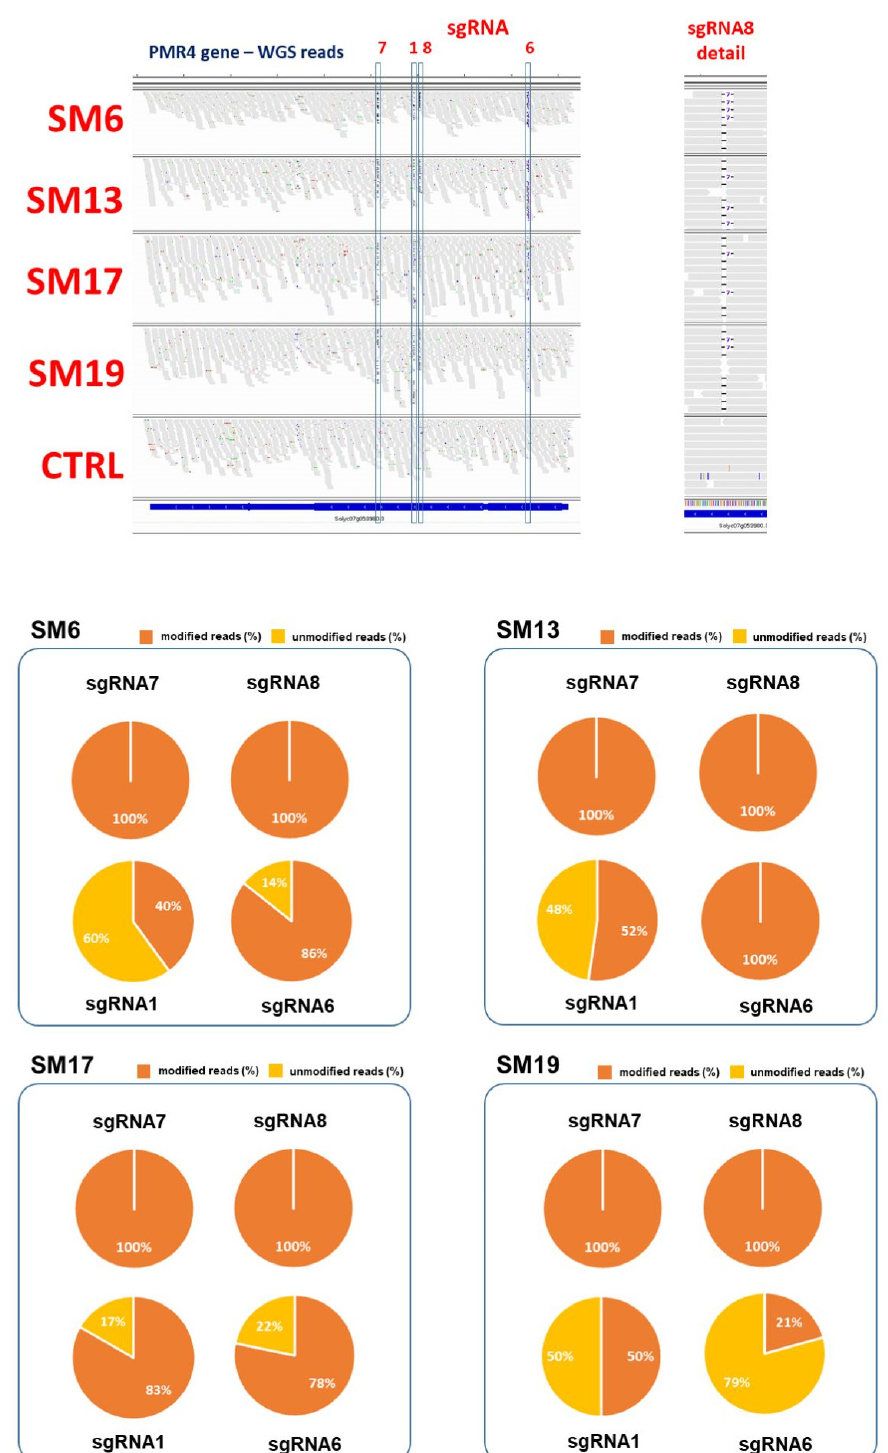
Figure 3. Sequence alignment view of the edited PMR4 gene at the level of the four sgRNAs in the four mutants and the control plant (top). A focus on sgRNA8 is shown on the right-hand side. Mutational status (%) for each sgRNA region and in all the assayed genotypes as revealed by the CRISPResso2 analysis (bottom).